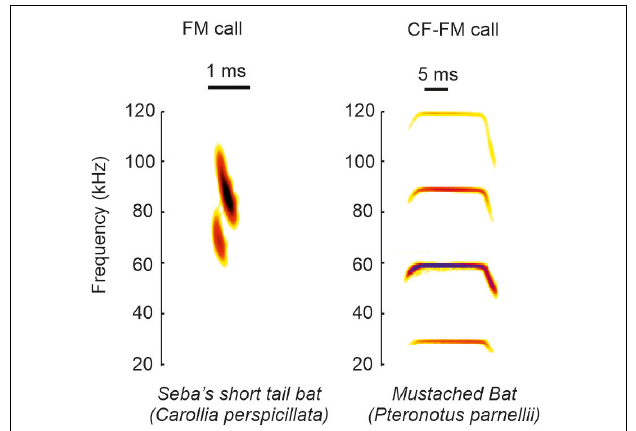
FIGURE 1 | Example calls of FM and CF-FM bats. The example spectrograms shown correspond to vocalization from the species Carollia perspicillata and Pteronotus parnellii